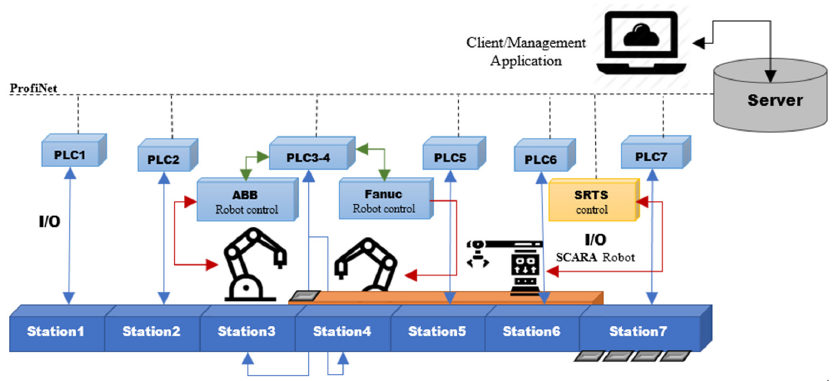
Figure 2. Flexible manufacturing system structure.